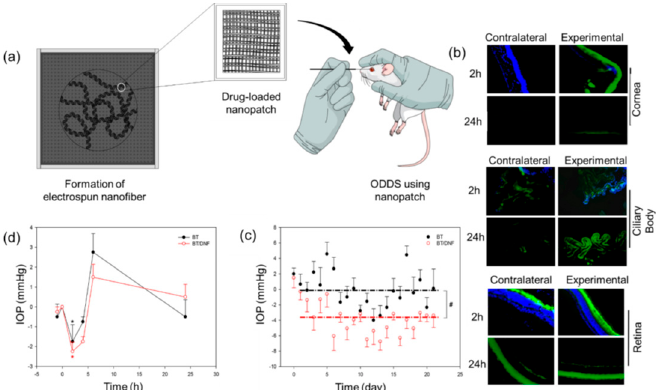
Figure 5. ( a ) An illustrative diagram of nanofiber-based ophthalmic drug delivery system; ( b ) Ocular deposition of dendrimer nanofibers (DNF). Brown Norway rats (BNR) (n = 3) received a DNF-FITC mat topically in the right eye (experimental eye), whereas the left eye received no treatment